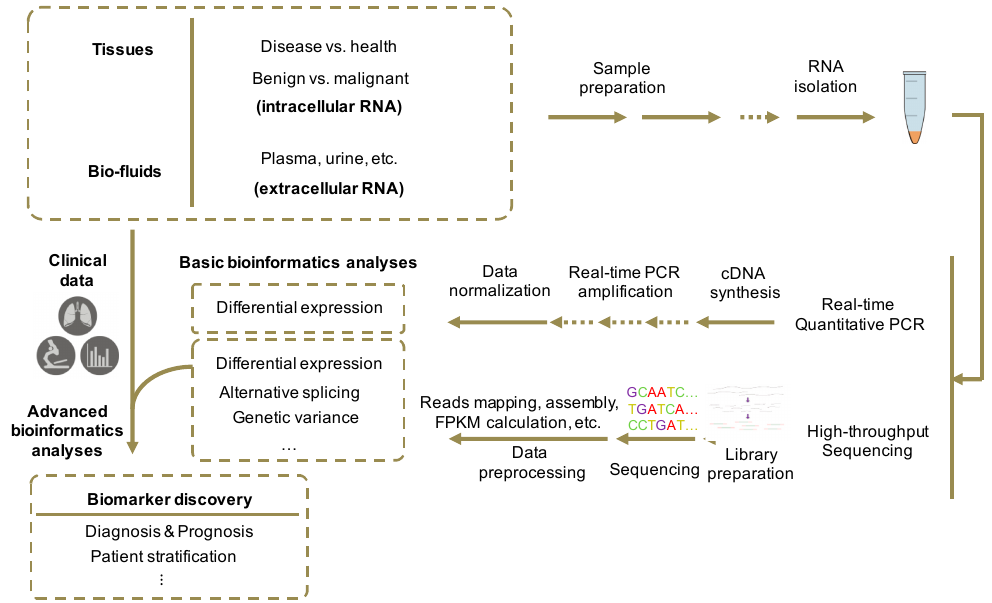
Figure 3. Experimental and analytical procedures for the identification of novel RNA biomarkers. First, tissues and/or bio ‐ fluids are collected from both patients and health individuals.